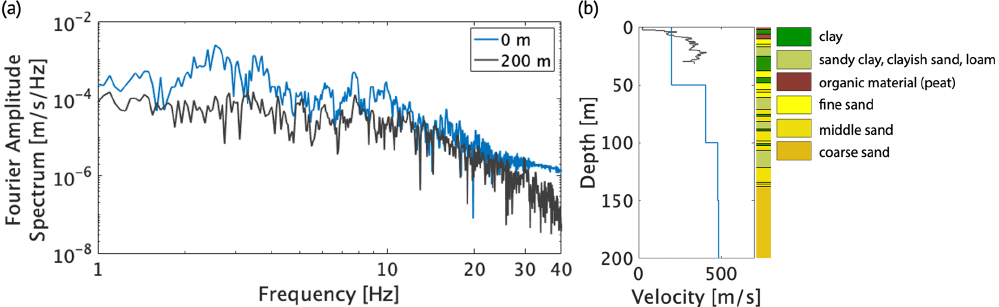
Figure 3. (a) Particle velocity Fourier amplitude spectrum measured on the radial component for the 200m (grey) and surface seismometer (blue) for borehole G24 for a 20s time window of the 8 January 2018 Zeerijp M 3.4 earthquake. Borehole G24 has an epicentral distance of 10km. (b) Shear-wave velocity profile for G24 with the interval velocities from Hofman et al. (2017) in blue and the shear-wave velocity from the adjacent SCPT over the top 30m (black line). The corresponding lithological profile is derived from GeoTOP (https://www.dinoloket.nl/ en/subsurface-models, last access: 15 October